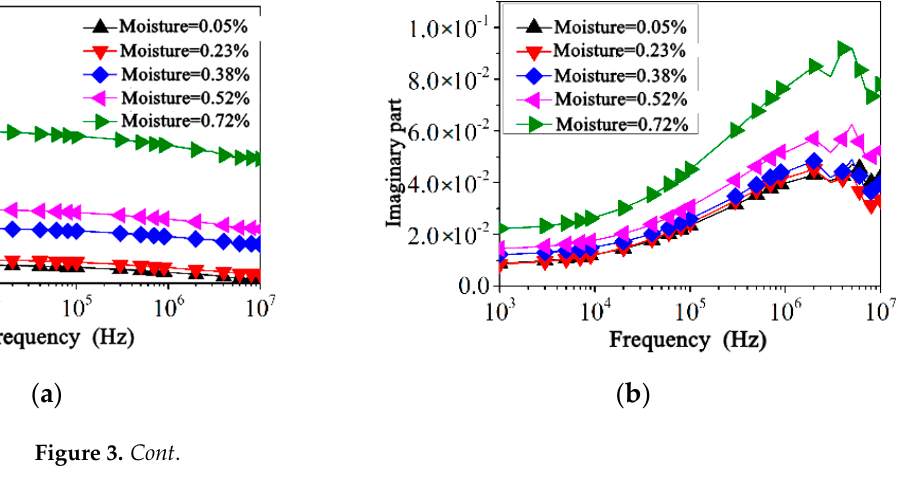
Figure 2. FDS measuring device.